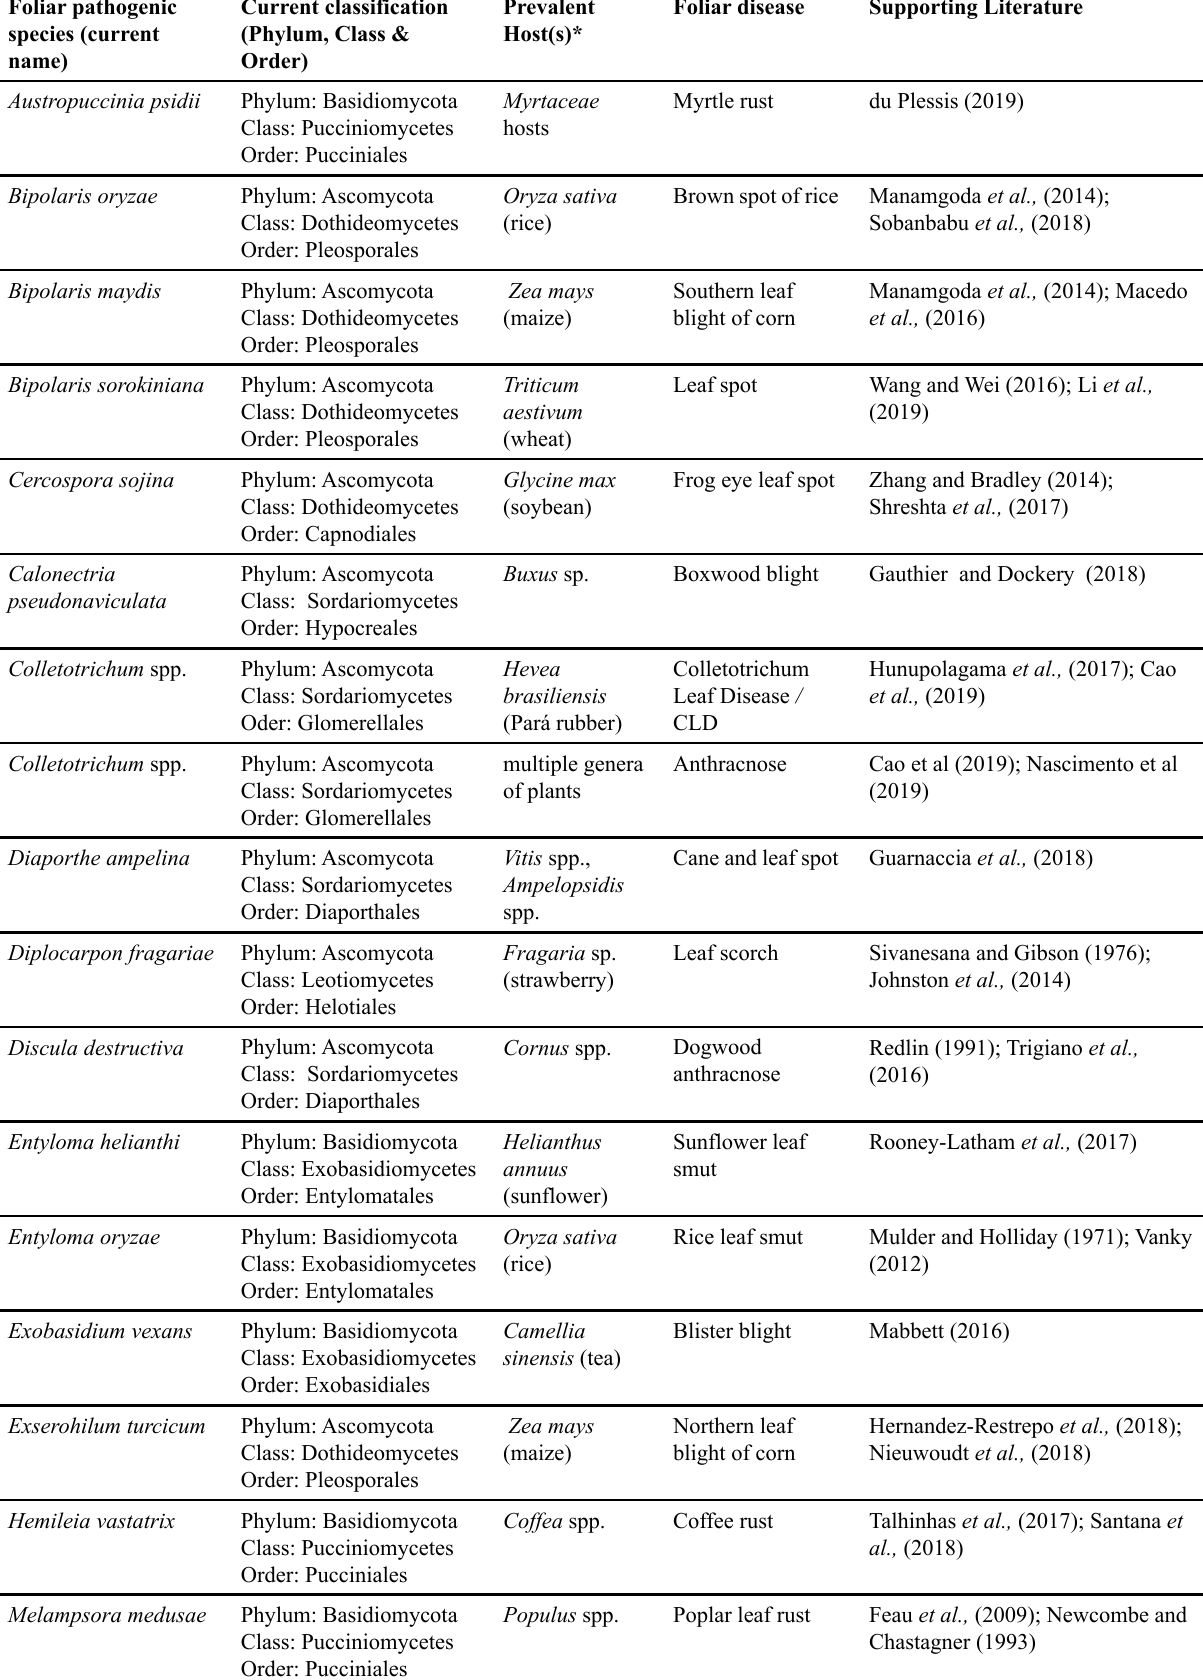
Table 1: Examples of destructive foliar pathogenic fungal species causing diseases on crops and ornamentals, their current classification, prevalent host(s), disease and supporting